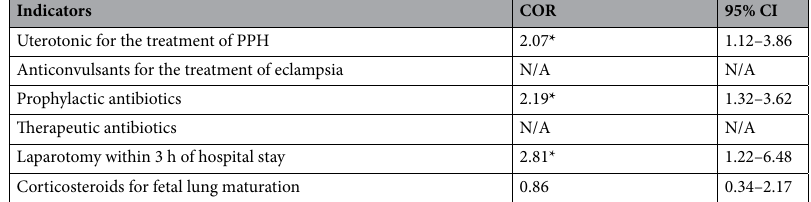
Table 3. Bivariate logistic regression analysis of process indicators as determinants of maternal outcome among women admitted to Keren Hospital. *Significant at p = 0.05, N/A-not applicable since there are cells containing less than 5 observations.